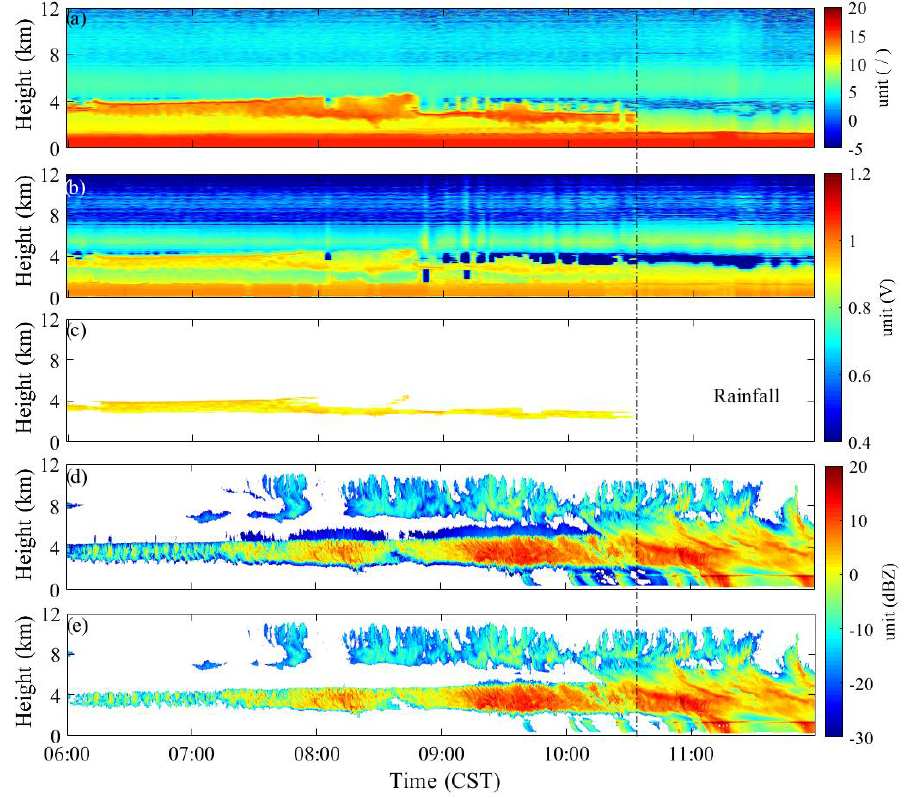
Figure 12. THI of echo signal of the lidar and MMCR on 10 March, 2021. (a) SNR of P new_sf , (b) P new_sp of the 1064nm signal, (c) cloud information detection results, (d) reflectivity factor without quality control, and (e) reflectivity factor with quality control (black dotted line indicates rainfall time).